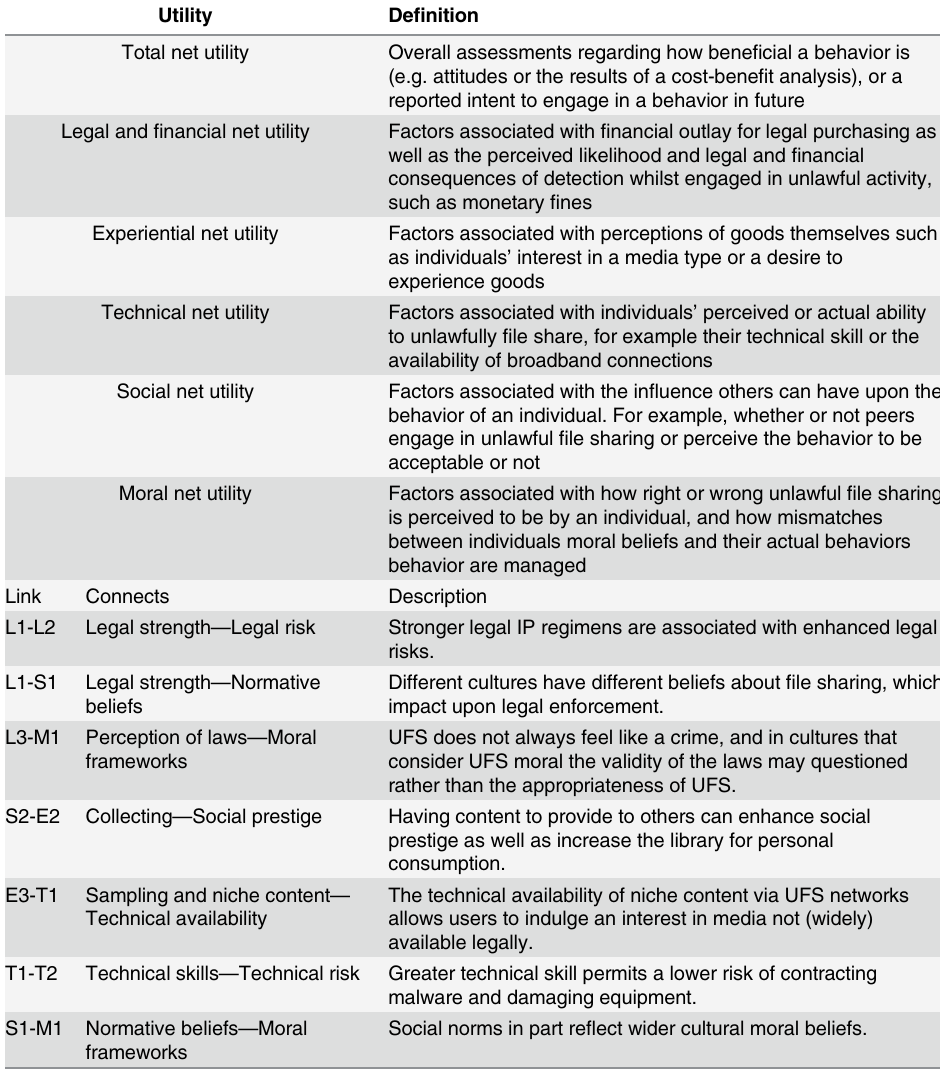
Table 6. Definition of categories and links in conceptual framework on